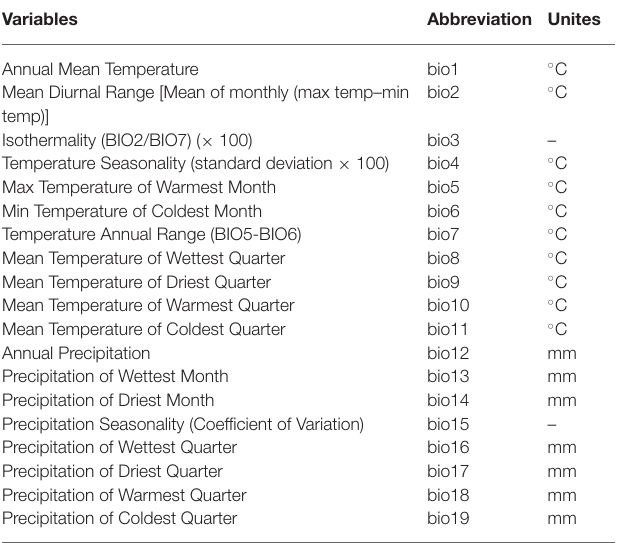
TABLE 1 | List of climate